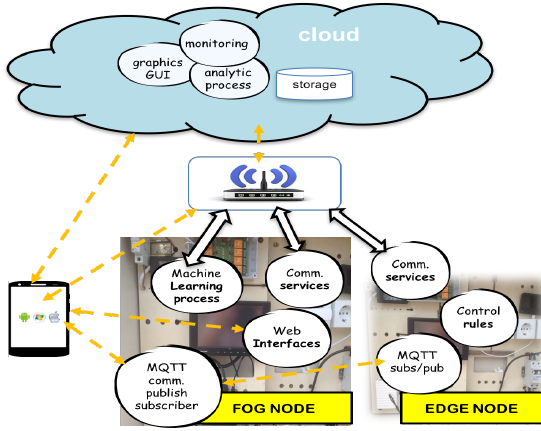
Figure 9. Communication and processes on edge and fog nodes.